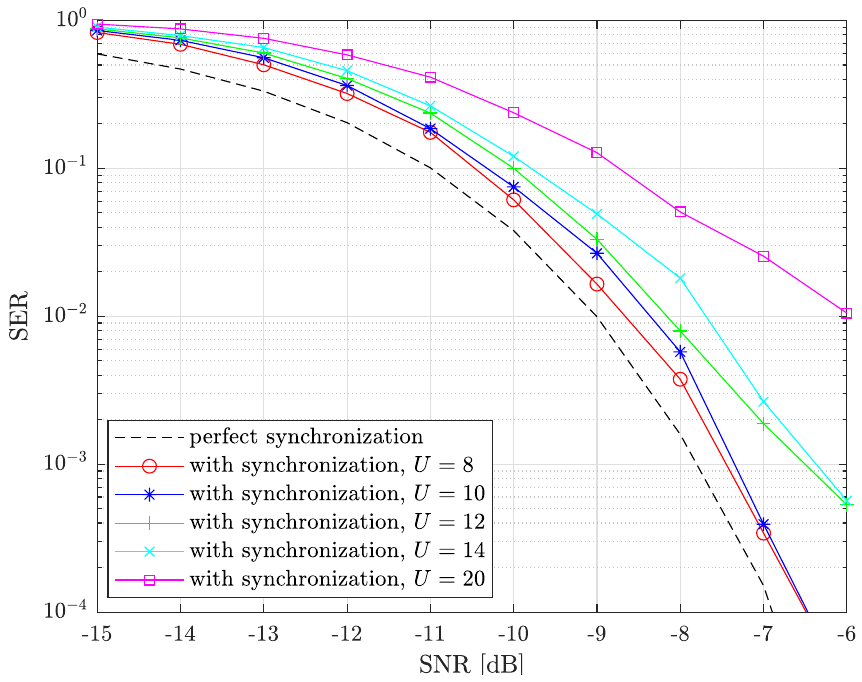
15, 14, . . . , 6 , several self-jamming peaks {− − − }